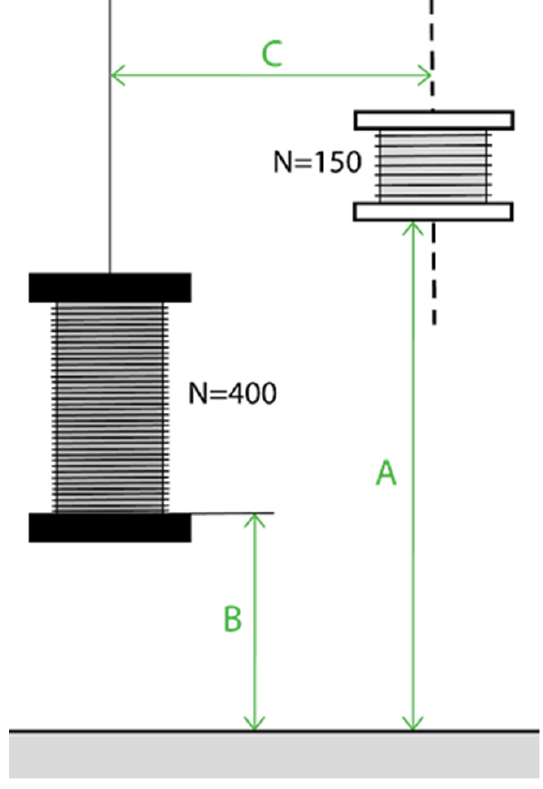
Figure 3. Diagram of the position parameters A, B and C to be varied during Test 4.